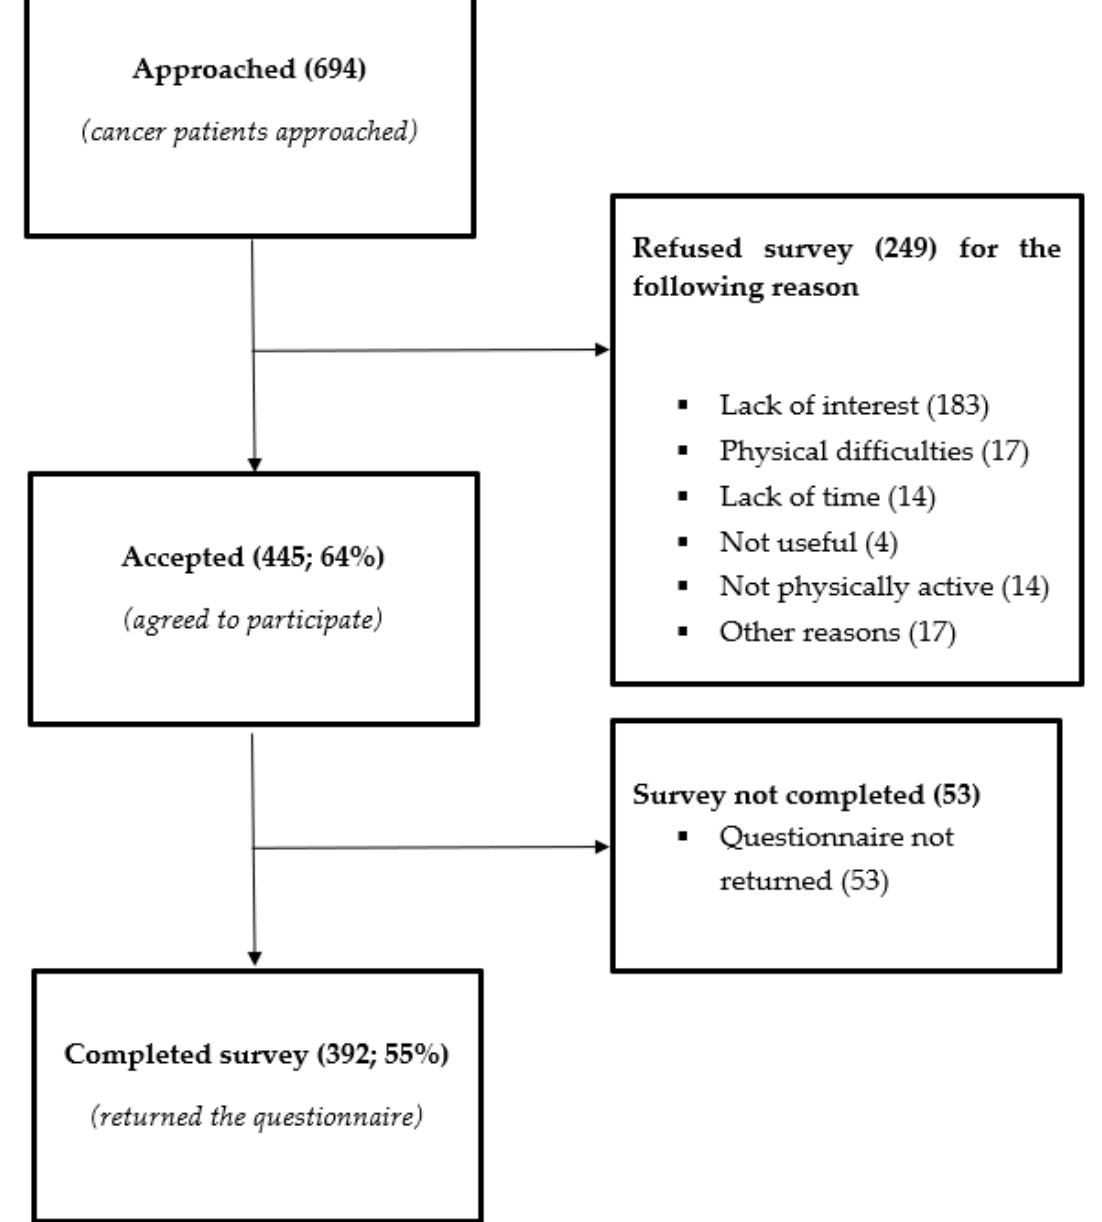
Figure 1. Flow of participants through the study.